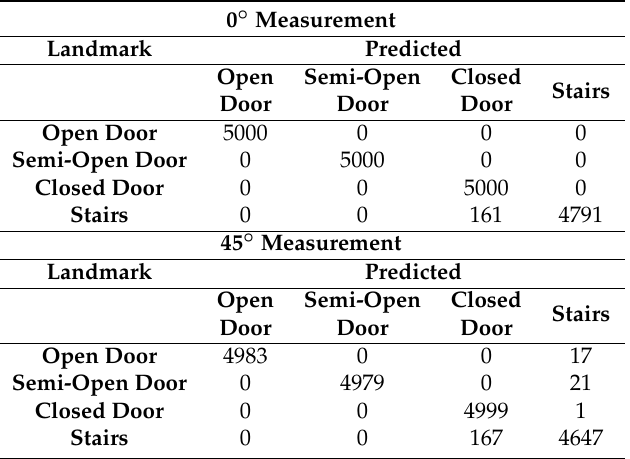
Table 2. Recognition confusion matrices.